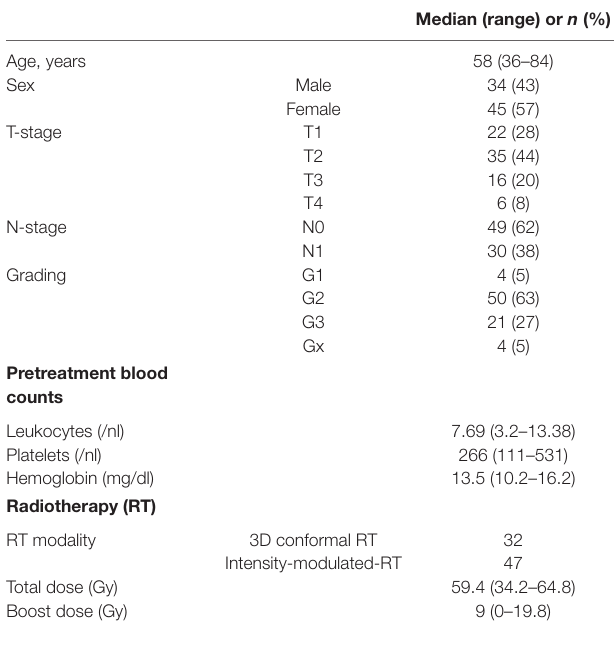
Table 1 | Patients, tumor, and blood